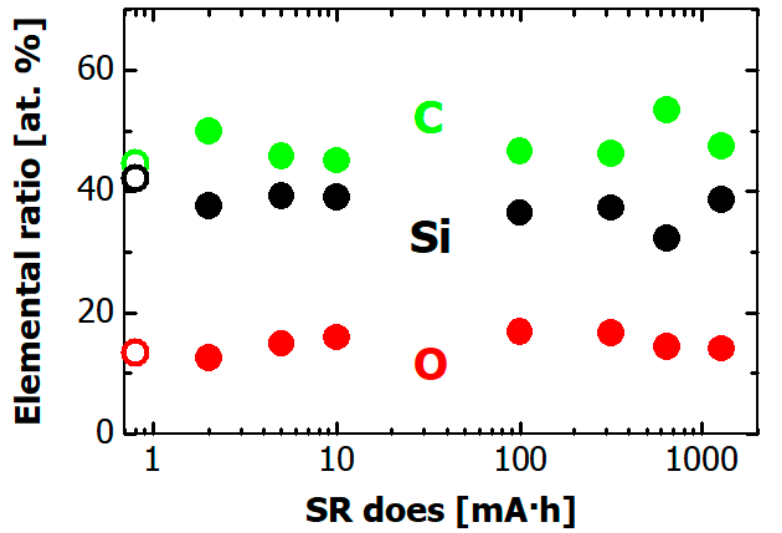
Figure 8. Dependence on SR dose of the elemental ratio of hydrogenated Si-DLC film surface as measured by XPS. Black, green, and red circles respectively show silicon, carbon, and oxygen contents. The open circles indicate carbon, silicon, and oxygen contents before the SR irradiation.